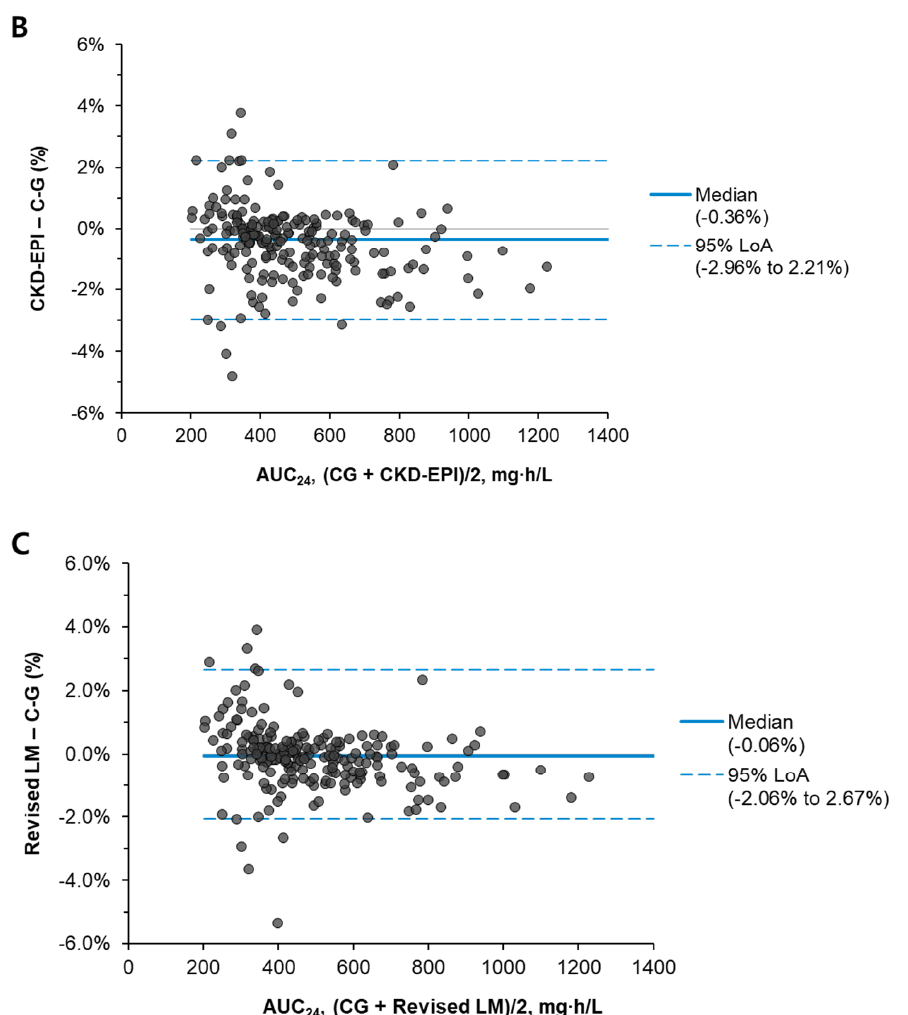
Figure 2. Bland–Altman plots for AUC 24 of vancomycin according to the estimated glomerular filtration rate equations. ( A ) Between C-G and MDRD. ( B ) Between C-G and CKD-EPI. ( C ) Between C-G and the revised LM. Outliers were excluded (( A ), n = 2; ( B ), n = 2; and ( C ), n = 3). See Appendix A (Figure A1) for all data results, including outliers. Abbreviations: AUC, area under the curve over 24 h; C-G, Cockcroft-Gault; CKD-EPI, Chronic Kidney Disease Epidemiology Collaboration; MDRD, Modification of Diet in Renal Disease; LoA, limit of agreement; and LM, Lund–Malmö.